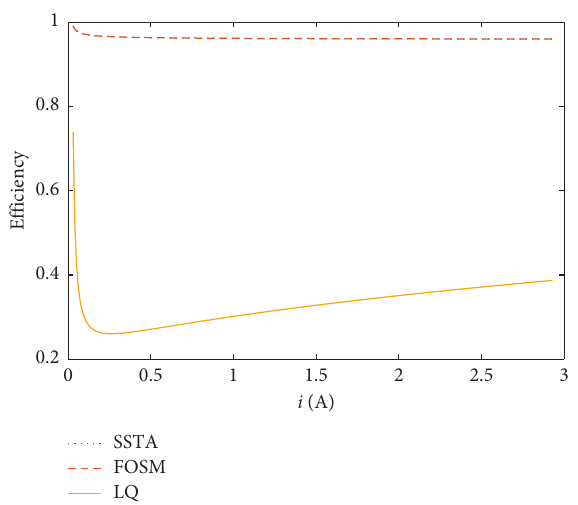
Figure 9: Efficiency of the boost converter for different desired current